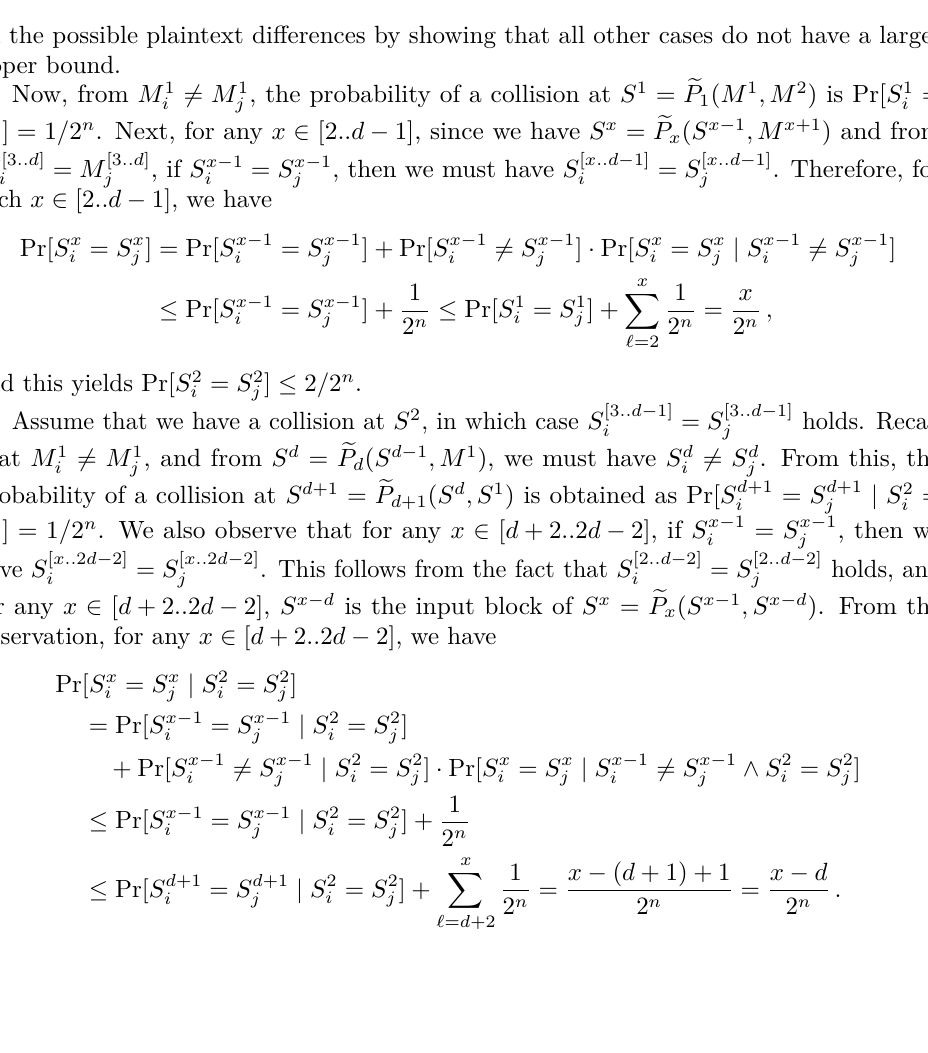
Figure 17: A table of Prob (∆ M [1 ..d ] , State ) with d = 4, r = 10, and Type = Bad 1 the upper bounds are shown, i.e., low order terms that do not contribute to the upper bound (e.g., terms with a negative coefficient) are